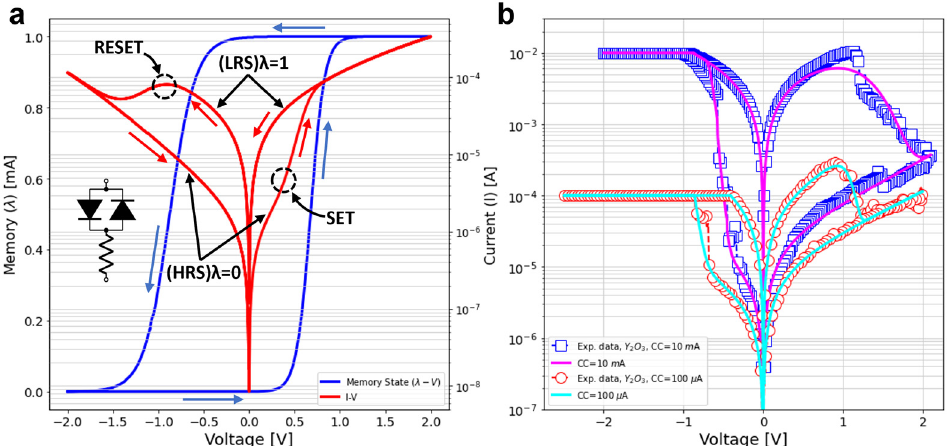
Figure 2. ( a ) Memory state ( λ , in blue) as a function of the applied voltage, defined by Equation (2). The inset on the left shows the equivalent circuit model for the current equation (Equation (1) including the series resistance. The diodes are driven by the memory state of the device and one diode is activated at a time. Typical I ‐ V characteristic for a memdiode obtained via simulation of the proposed model are superimposed. Current evolution is indicated by the blue arrows. ( b ) Experimental I ‐ V loops of Y 2 O 3 devices fabricated with an oxygen flow of 0.1 sccm and measured with current compliances of 10 mA (blue squares) and 100 μ A (red circles), both fitted with the DMM model.